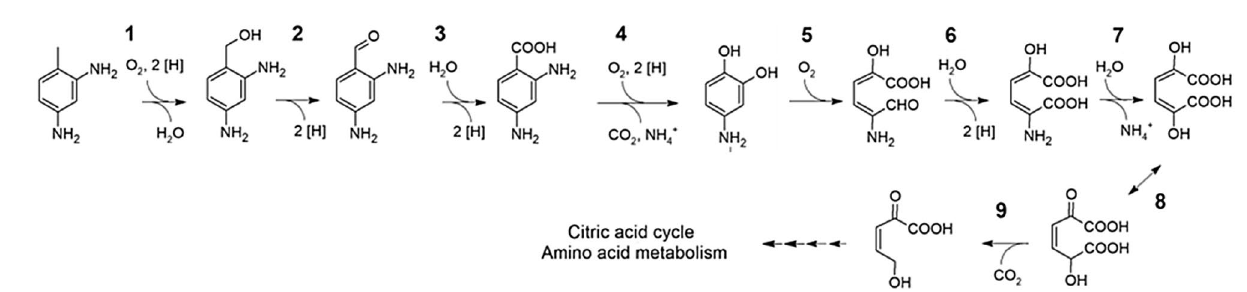
Figure 2. Proposed degradation pathway for 2,4-TDA in Pseudomonas capeferrum TDA1, via 4-aminoanthranilate (3), 4-aminocatechol (4), 4-amino-2-hydroxy-muconate semialdehyde (5) and 4-amino-2- hydroxy-muconate (6). The lower degradation pathway of 2,4-TDA needs to be elucidated in further studies.